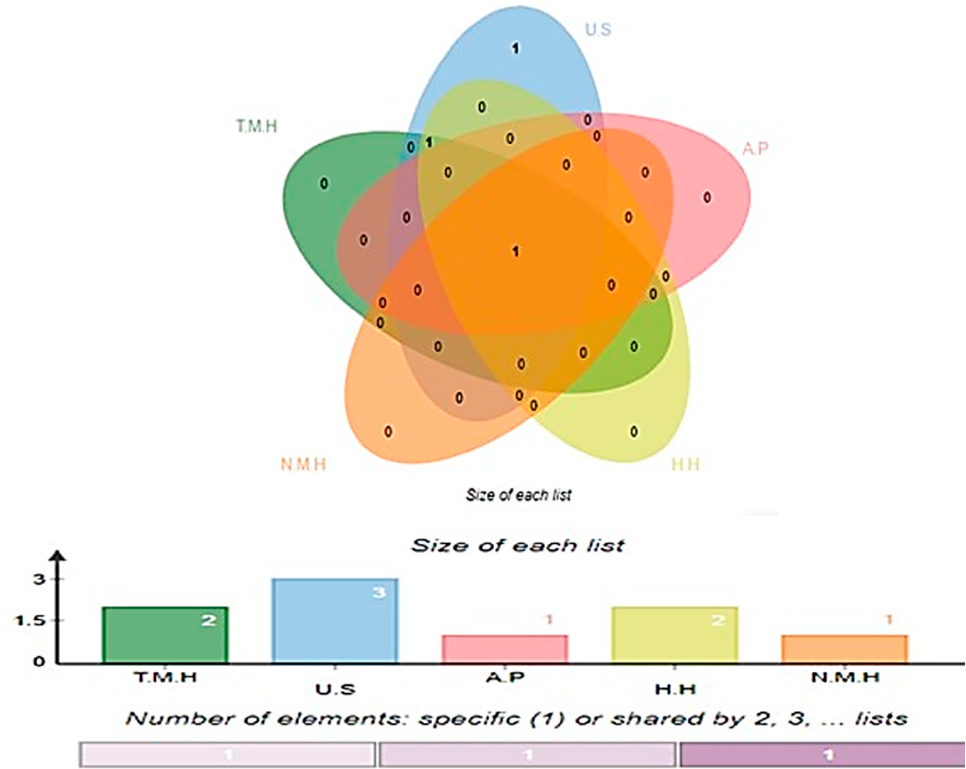
Figure 4. Discarded proteins having transmembrane helices (T.M.H), unstable (U.S), allergic proteins (A.P) human homologous (H.H) and normal microbiota homologous (N.M.H).